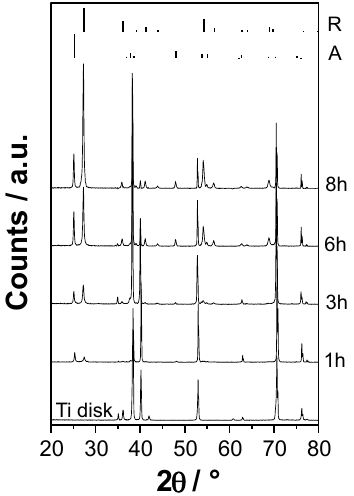
Figure 2. XRD patterns of the pristine Ti disk and of the TiO 2 coatings grown for different deposition time (1, 3, 6, and 8 h). The peak positions and relative intensities of the anatase (A) and rutile (R) phases are reported at the top of the figure for comparison. Table 1. Film thickness, crystal phase composition, and band gap of the investigated TiO 2 coatings.